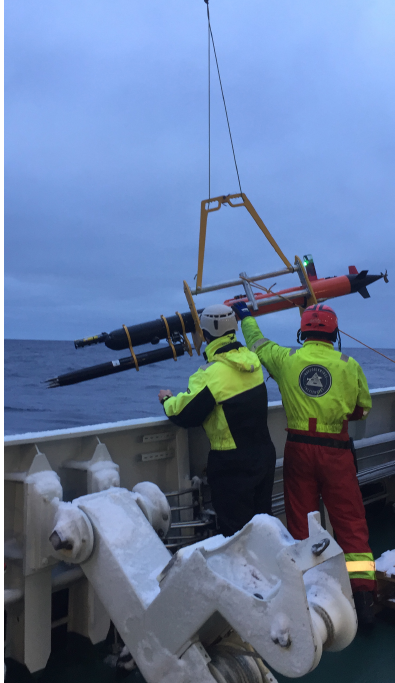
Figure 3. Deployment of MicroRider-1000LP mounted below the light AUV “Harald” in the Barents Sea at 07:30 on 26 Febru- ary 2021. From left: co-author Tore Mo-Bjørkelund and crew mem- ber Svein Are Simonsen. Photographer: Frank Nilsen, University Centre in